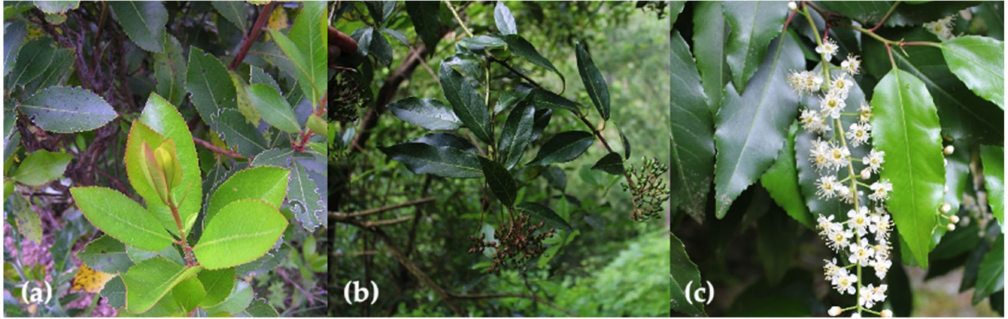
Figure 5. Pre-forested bushes with broad texture and slower combustibility. ( a ) Arbutus unedo ; ( b ) Viburnum tinus ; and ( c ) Prunus lusitanica .